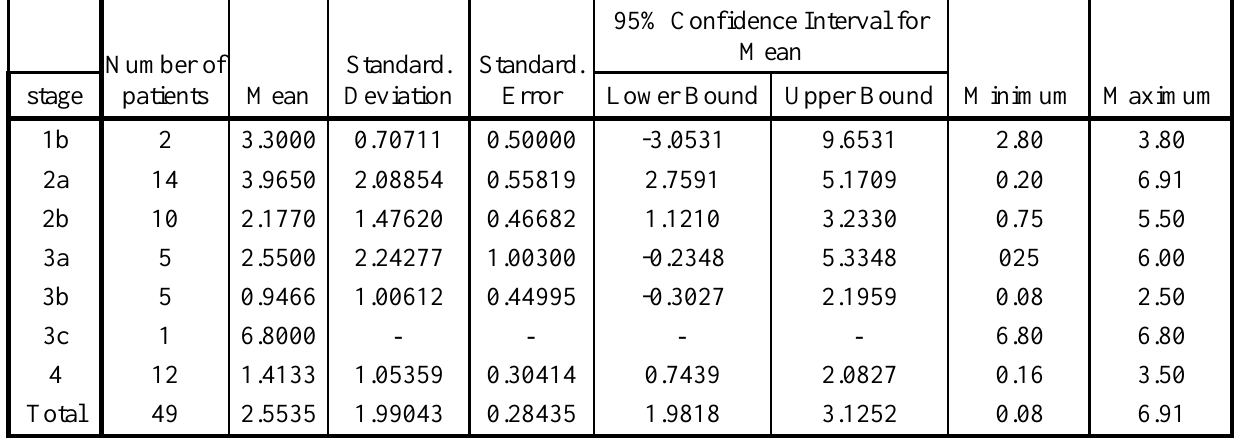
Table 5 : Correlation between the survival and stage of the disease (Test: one way